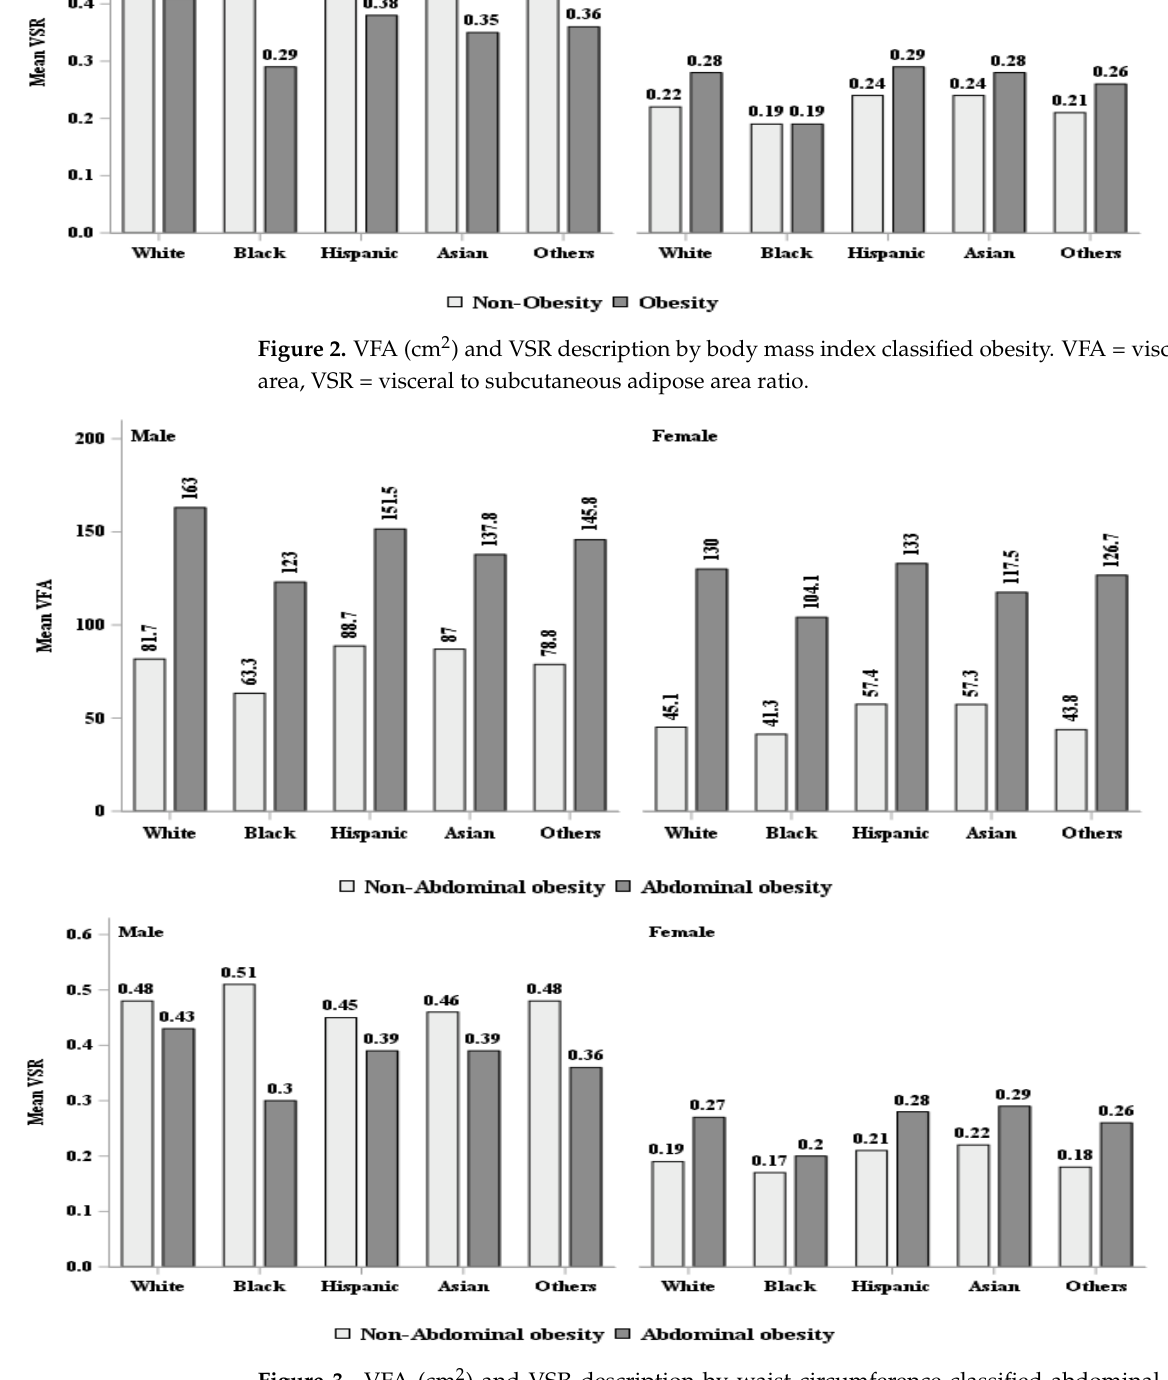
Figure 3. VFA (cm 2 ) and VSR description by waist circumference classified abdominal obesity. VFA = visceral fat area, VSR = visceral to subcutaneous adipose area ratio. The analyses revealed linear relationships between BMI and VFA or WC and VFA (Figure 4). More specifically, after adjustment for demographic variables, BMI was posi- tively associated with VFA ( β = 5.86, 95% CI: 5.56, 6.15, r 2 = 0.609, p < 0.001). A similar pattern was observed across different racial/ethnic groups, male and female groups,